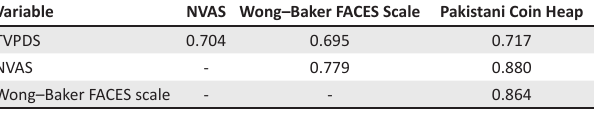
TABLE 2: A correlation matrix analysis of the four pain scales.